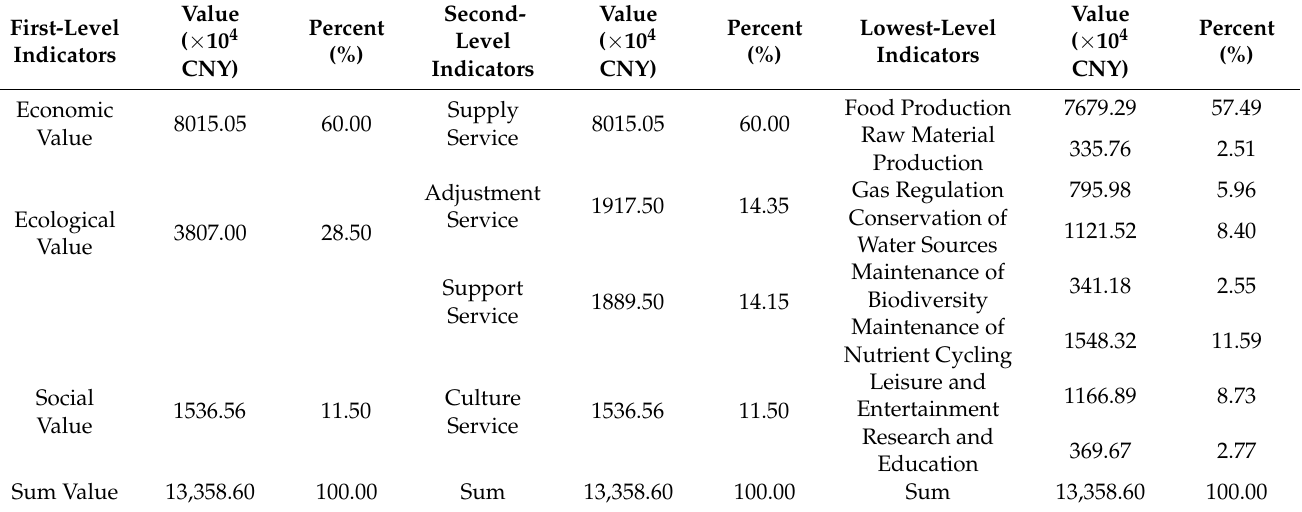
Table 6. The results of the ecological economic method to evaluate the ESV of the Huanghe